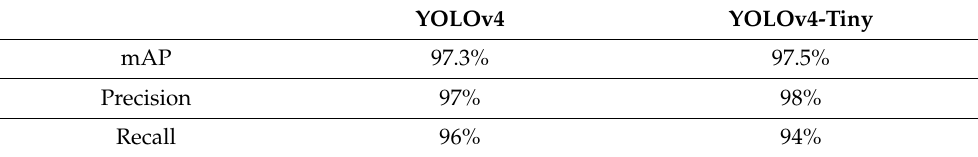
Table 22. YOLOv4 and YOLOv4-Tiny training and testing results for a different